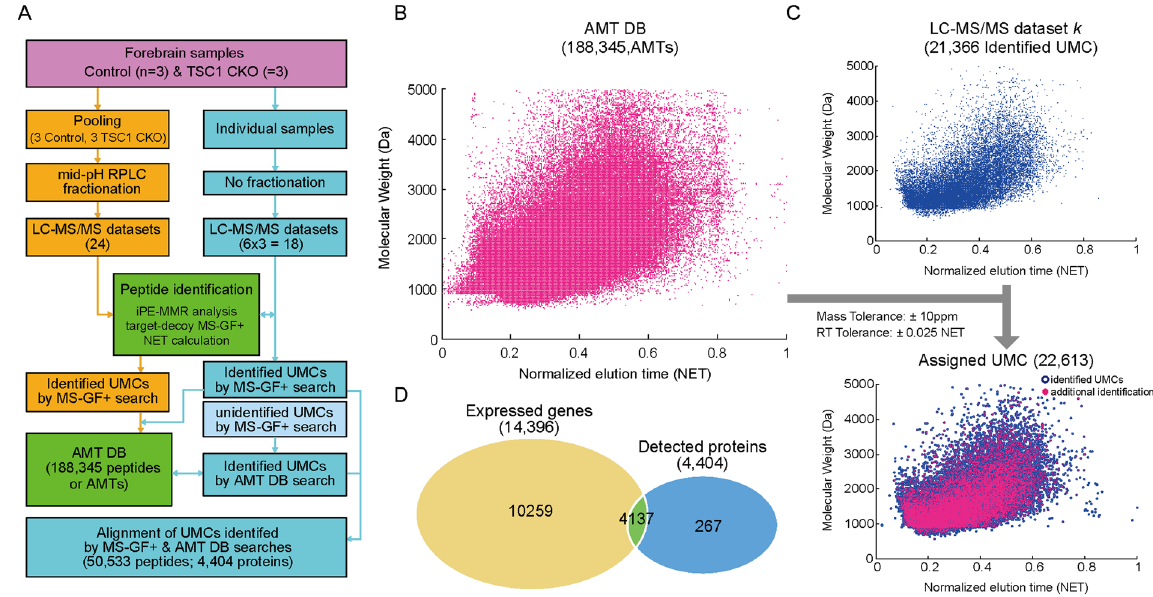
Figure 1. The master AMT DB. ( A ) The overall scheme of AMT DB construction. A total of 42 datasets (24 + 18 from left and right branches, respectively) were generated from LC-MS/MS analysis. For individual datasets, UMCs assigned with protein IDs (identified UMCs) were identified using i PE-MMR analysis and target-decoy MS-GF + search and then used to construct the AMT DB. ( B , C ) Utilization of AMT DB to assign protein IDs to unidentified UMCs. The 188,345 AMTs (magenta dots) in the AMT DB are visualized in a 2D (NET and molecular weight) scatter plot ( B ). For a LC-MS/MS dataset (dataset k ), the identified UMCs (blue dots) are shown in the upper scatter plot. By matching unidentified UMCs in this dataset with AMTs using the indicated mass and NET tolerances, a subset of unidentified UMCs (magenta dots) were assigned with protein IDs. These matched UMCs are shown in the bottom scatter plot ( C ). ( D ) Relationships of expressed genes identified from mRNA-sequencing data with detected proteins from LC-MS/MS datasets. Numbers in parentheses denote the numbers of expressed genes and detected